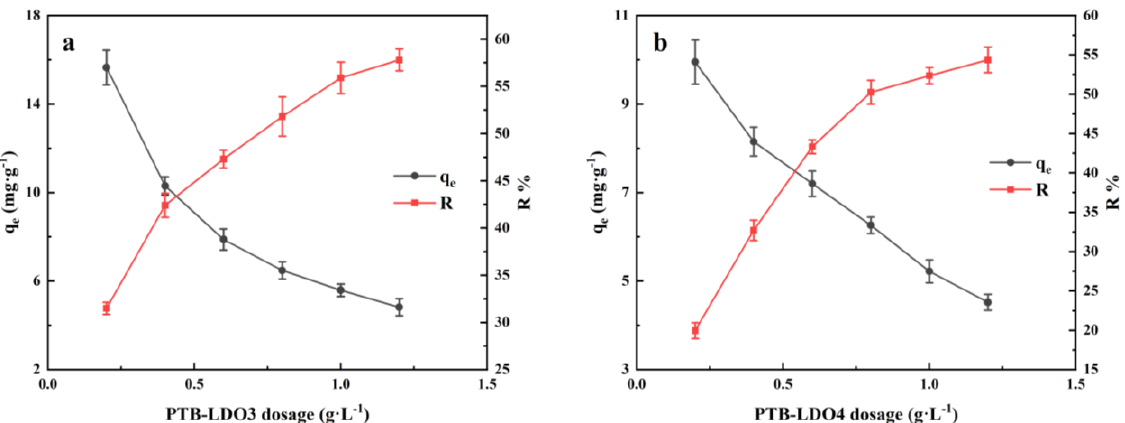
Figure 6. Effect of ( a ) PTB-LDO3 and ( b ) PTB-LDO4 dosages on the adsorption of F − (solution: 10 mg L −1 , pH 5.5, 6 h).